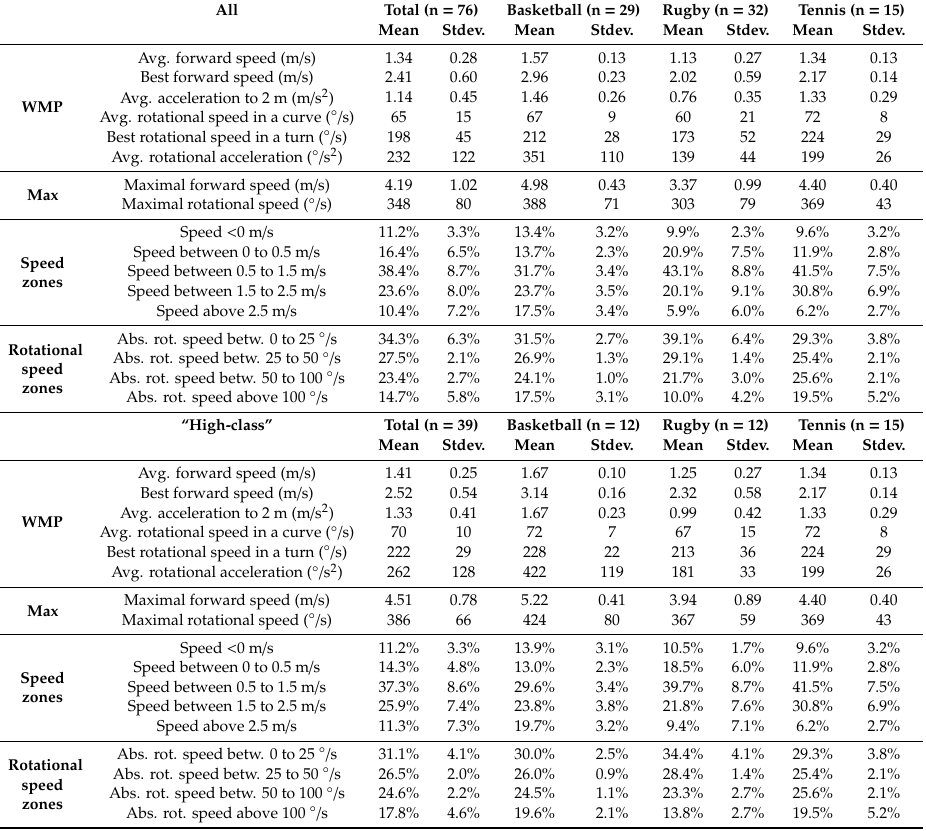
Table 2. Averages and standard deviations for the wheelchair mobility performance outcomes, the maximal values and the time spent in (rotational) speed zones for the three sports. The upper table shows the overall outcomes and the bottom table only the “high-class” athletes (WB, 3 + ; WR, 2.5 + ; WT, all).